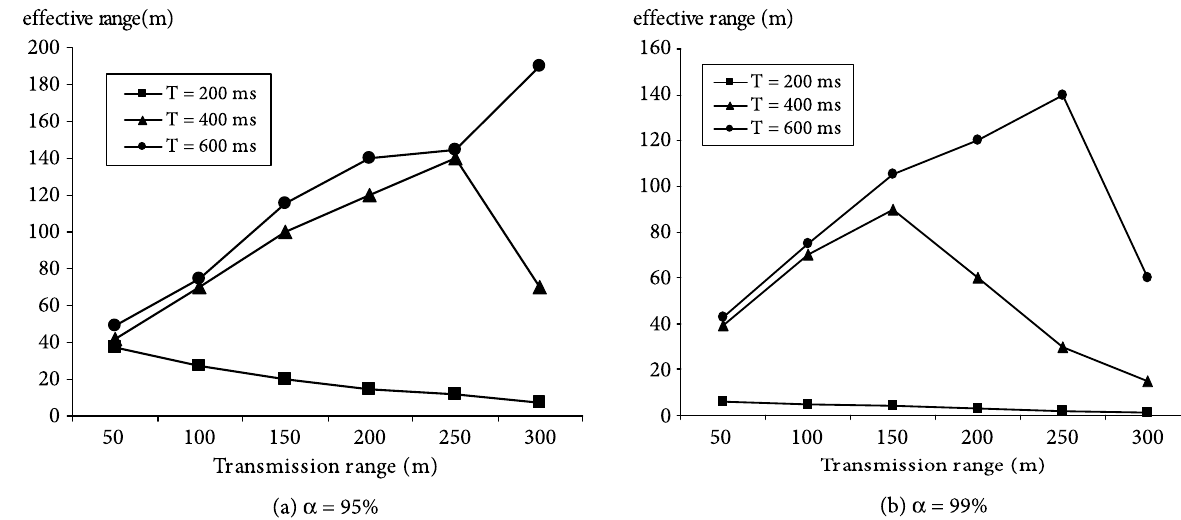
Fig. 6. Application’s effective range versus vehicle’s transmission range for different values of α and T in the 5P200B